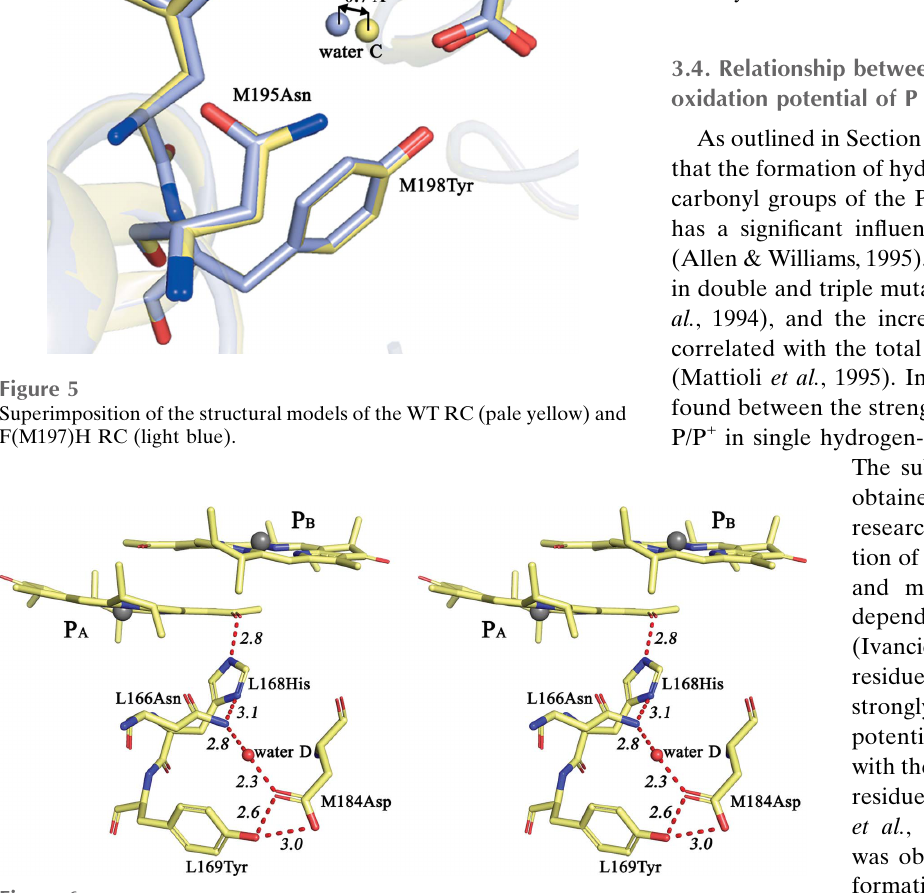
Figure 6 Stereoviews of the hydrogen-bonding network near His L168 in the R. sphaeroides RC structure. All distances are shown in A˚